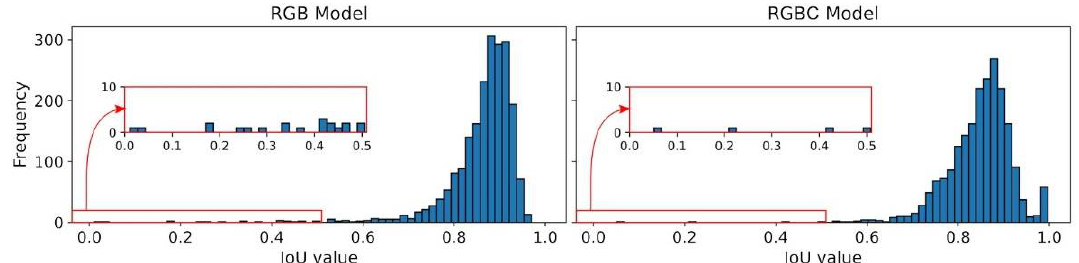
Figure 11. Histogram of IoU values from models.